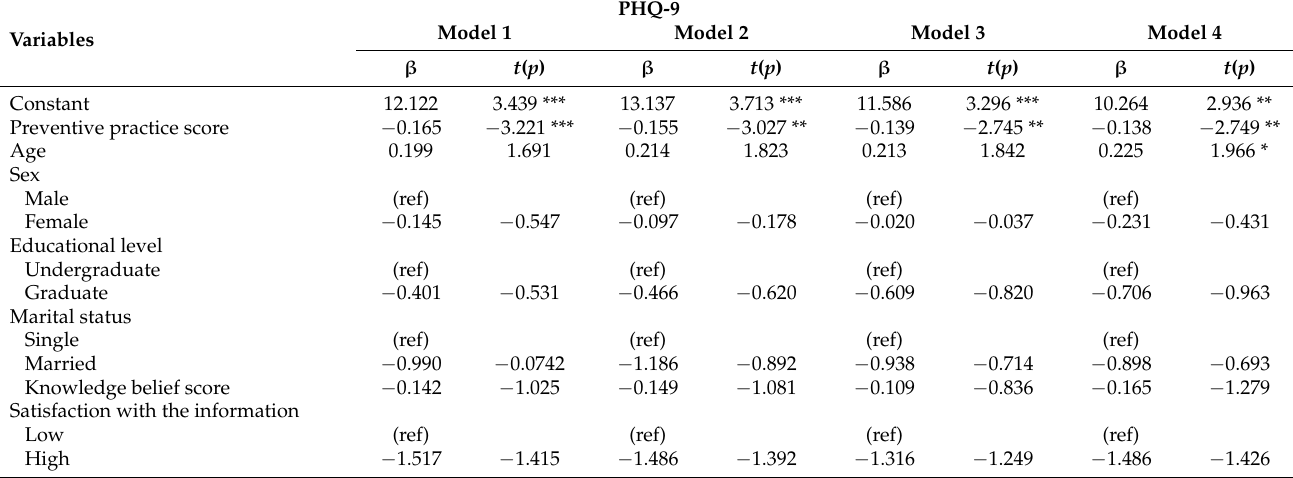
Table 6. Hierarchical regression analysis of the determinants of depression using the PHQ-9 ( n = 420).